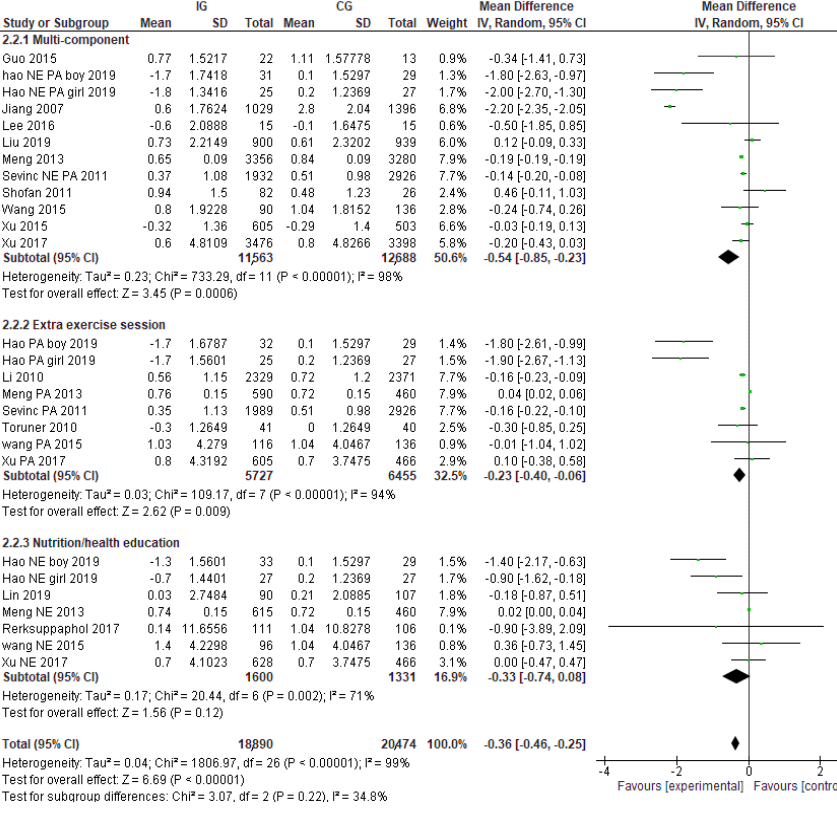
Figure 3. Pooled effects on BMI and the differences between multi-component interventions, nutri- tion education, and extra exercise prescription. education, and extra exercise